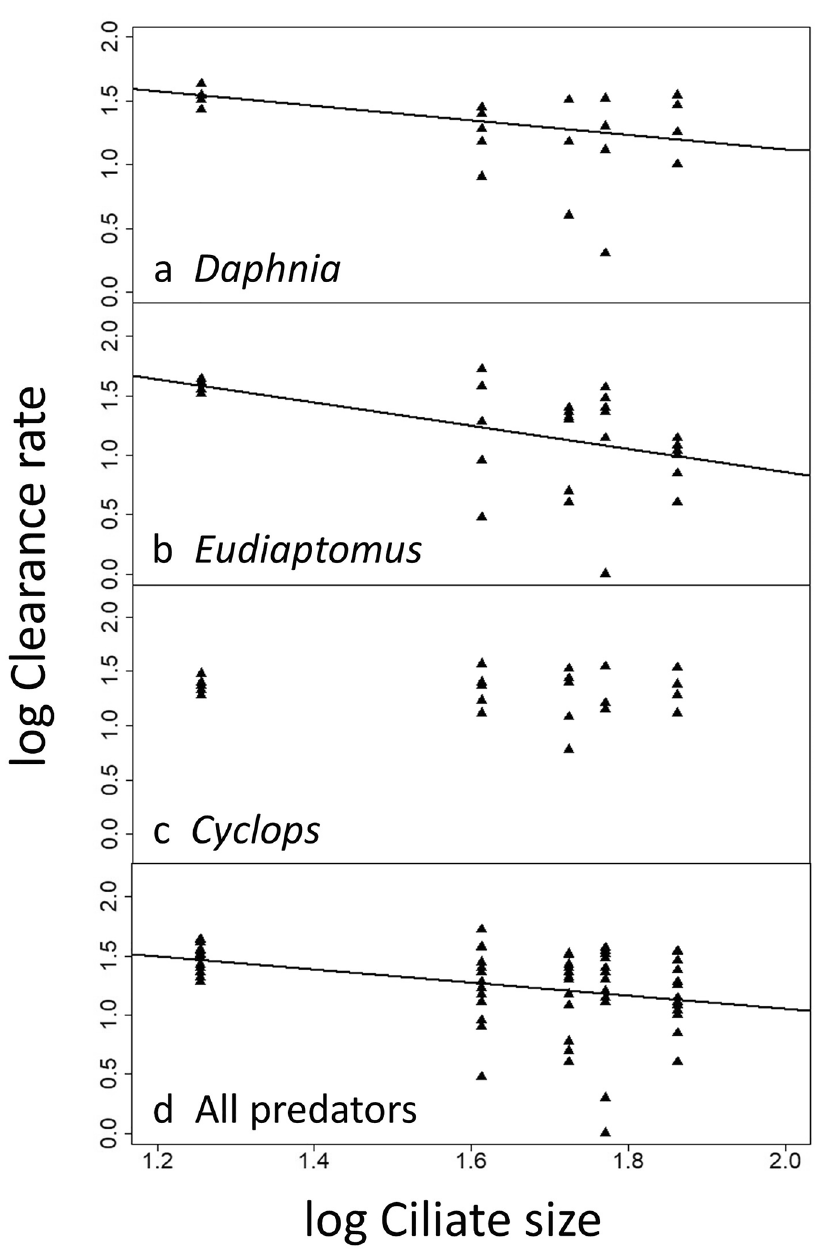
Figure 3. Log 10 –transformed clearance rates (logCL, in mL individual −1 d −1 ) of the three predators (a–c) and all predators combined (d) vs ciliate size. Data were fitted by a power curve (y = ax b ; plot a) and by OLS (y = kx + c; plots b,